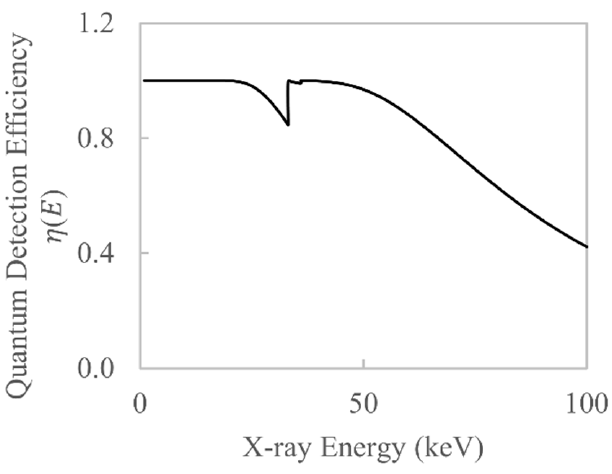
Figure 3. Quantum detection efficiency for a 600-µm-thick CsI scintillator calculated using Equa- tion (1).